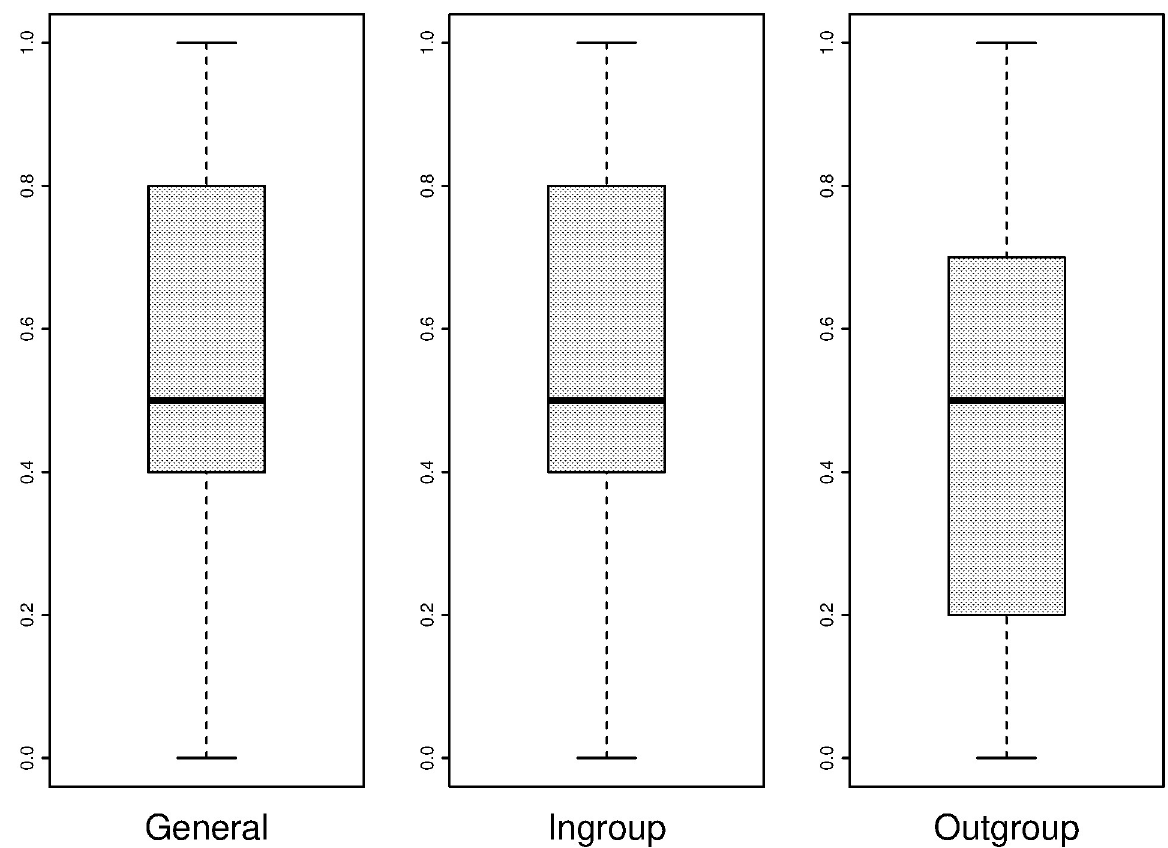
Fig 6. Trust of players in general (left), ingroup (centre) and outgroup (right) players as displayed in the IG.